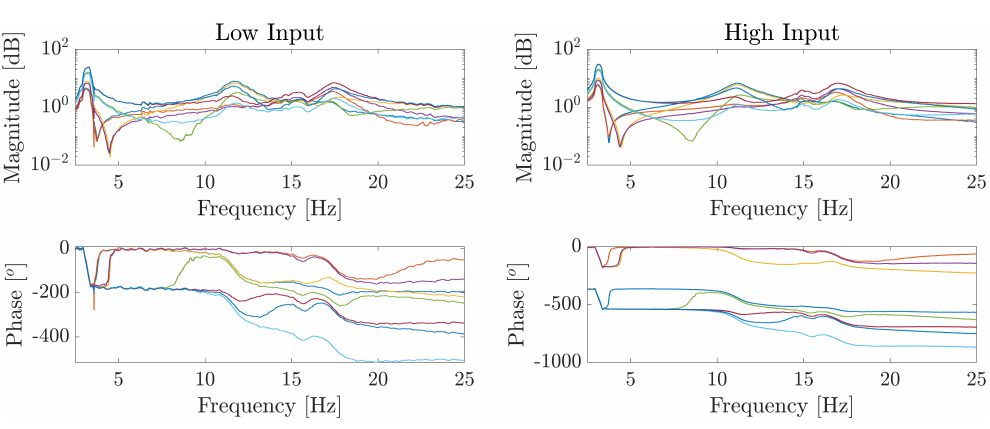
Figure 20. Full Wing: FRFs of the low- and high-input scenarios. All channels are superimposed for conciseness.